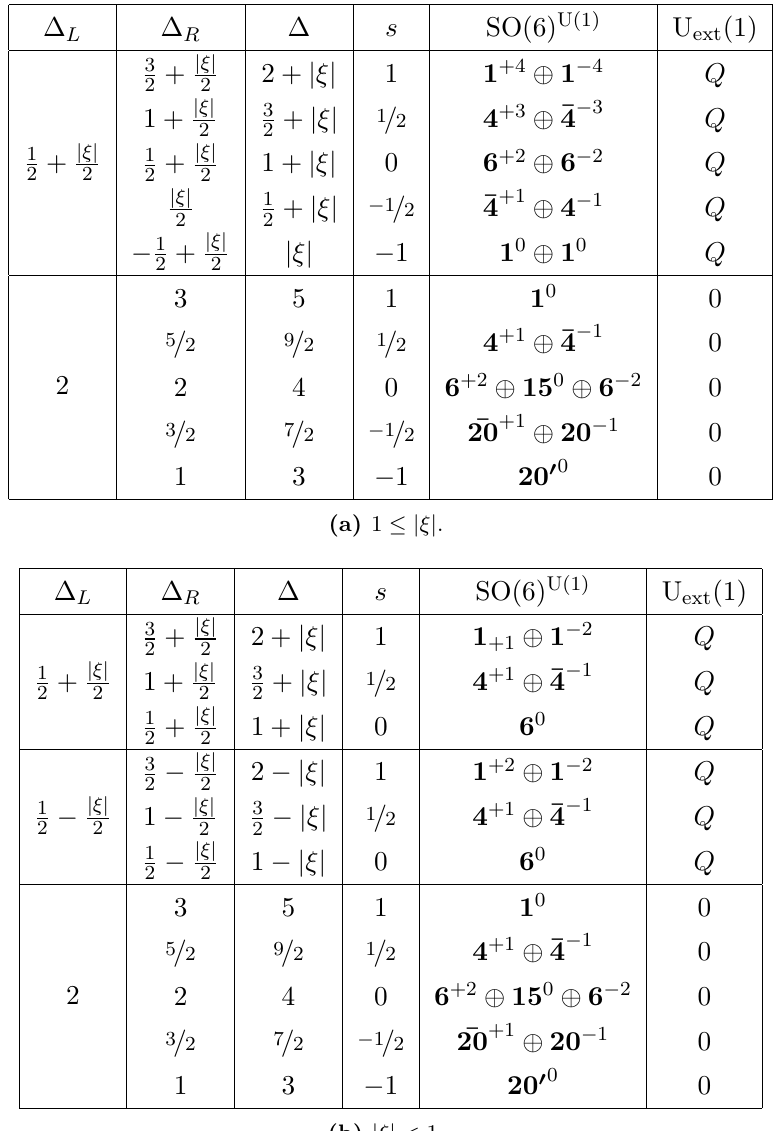
Table 15. Mass spectra for the SU(4 group is GL(6)